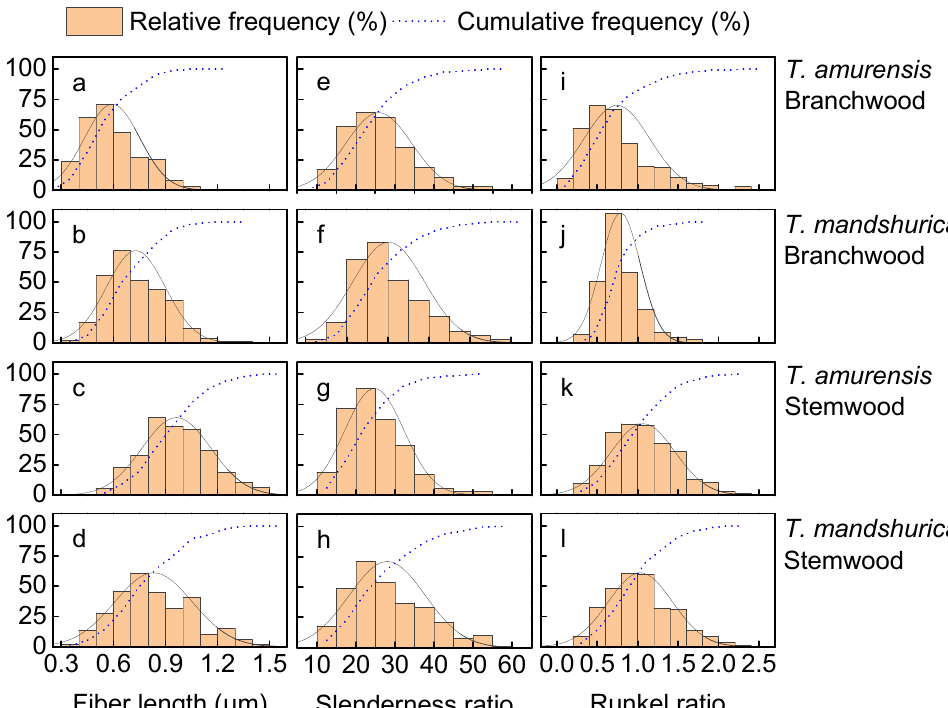
Figure 2. Relative frequency (histogram), cumulative frequency (do tt ed line), and fi tt ed normal dis- tribution (solid line) of fi ber length, slenderness ratio and Runkel ratio. ( a ) Fiber length of T. amuren-